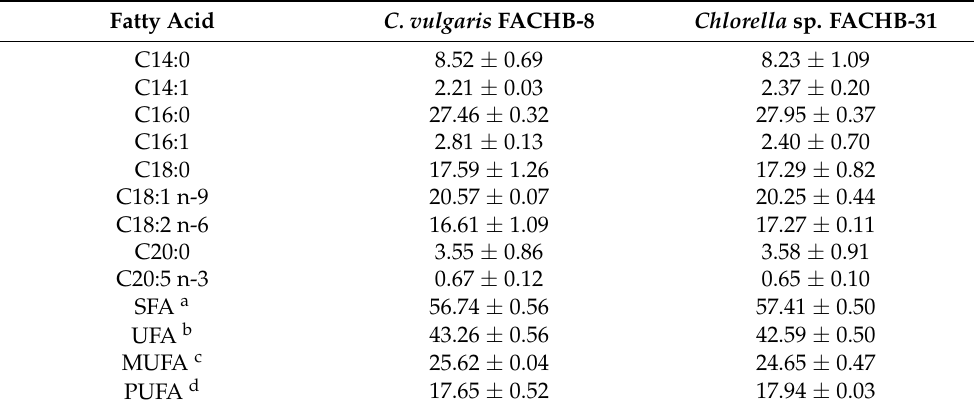
Table 4. Fatty acid composition (% total fatty acids) of FACHB-8 and FACHB-31 grown in undiluted ADSW after 15 days of